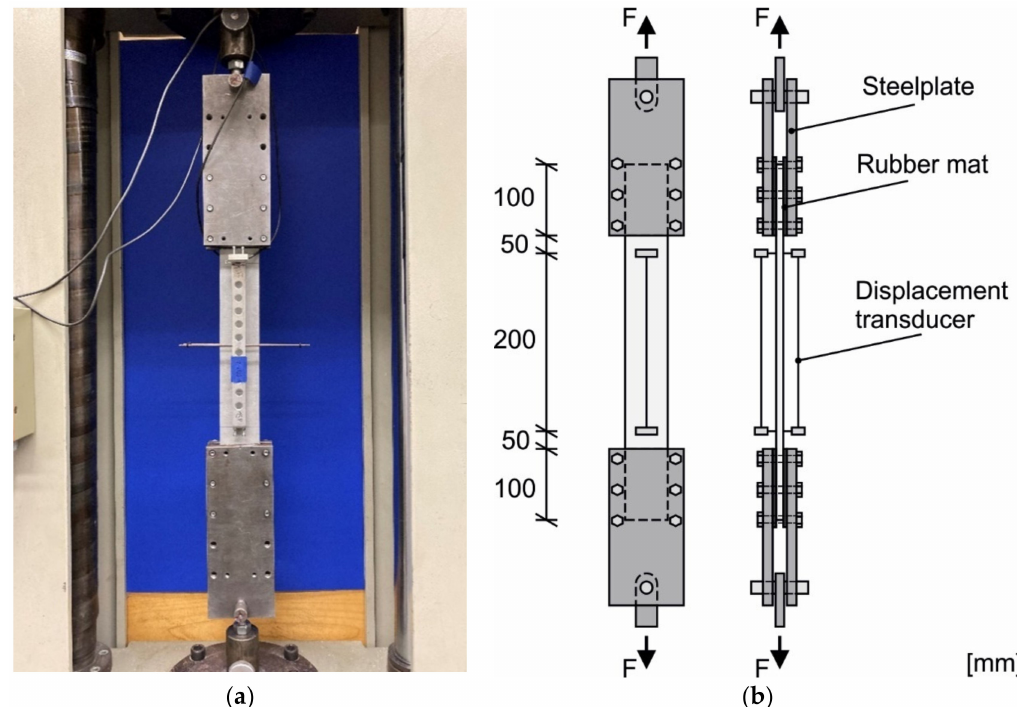
Figure 7. ( a ) Gripping system and specimen in the testing machine; ( b ) Scheme of the gripping system, specimen and measuring manner for determining the displacement during the uniaxial tension test, based on [40].